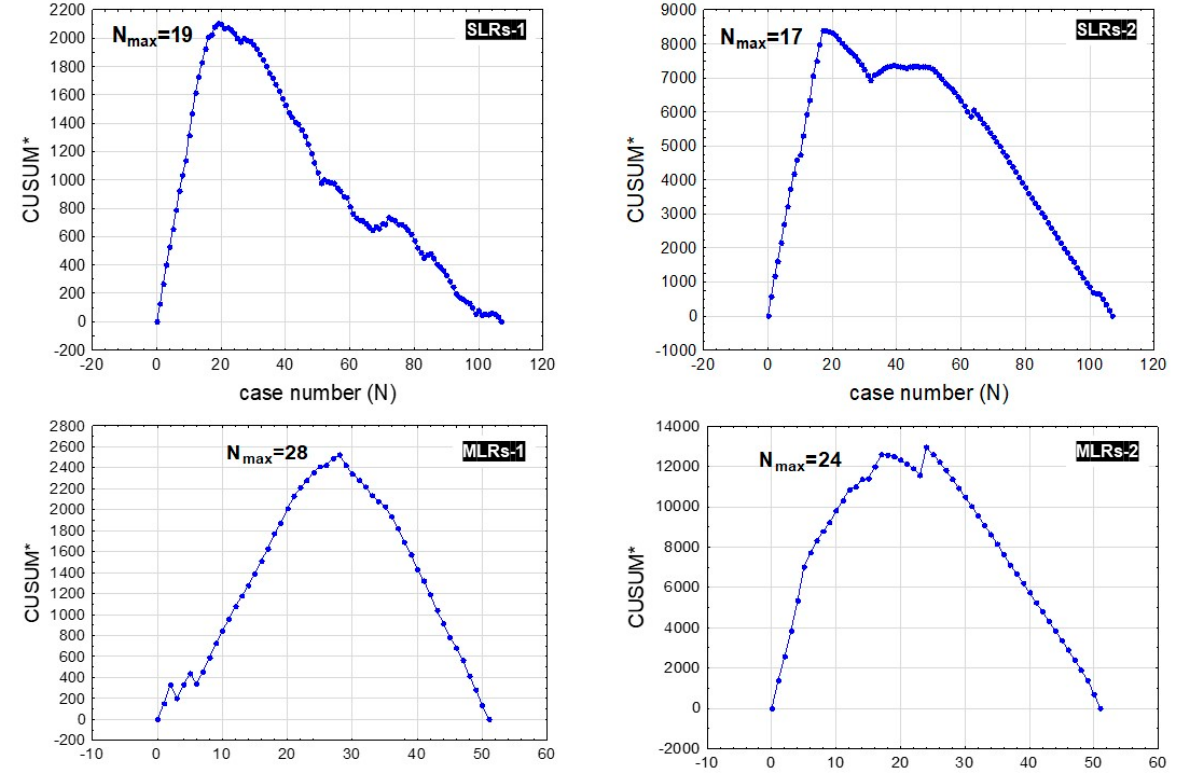
Figure 1. Cumulative sum control chart of operative (CUSUM *) time (SLRs-1) and intraoperative blood loss (SMLRs-2) against the number of patients with small liver resections (SMLs), and CUSUM time (MLRs-1) and intraoperative blood loss (MLRs-2) against number of patients with major liver resections (MLRs); N = 107.